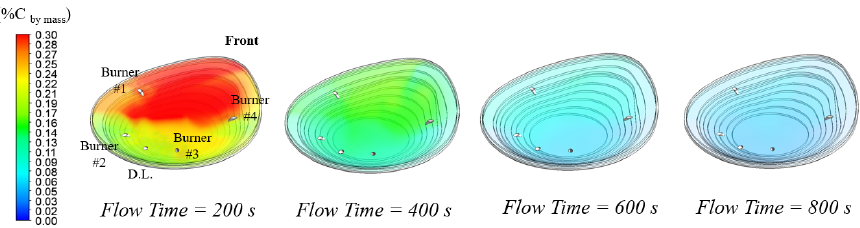
Figure 12. 3D carbon content distribution in the bath over time.